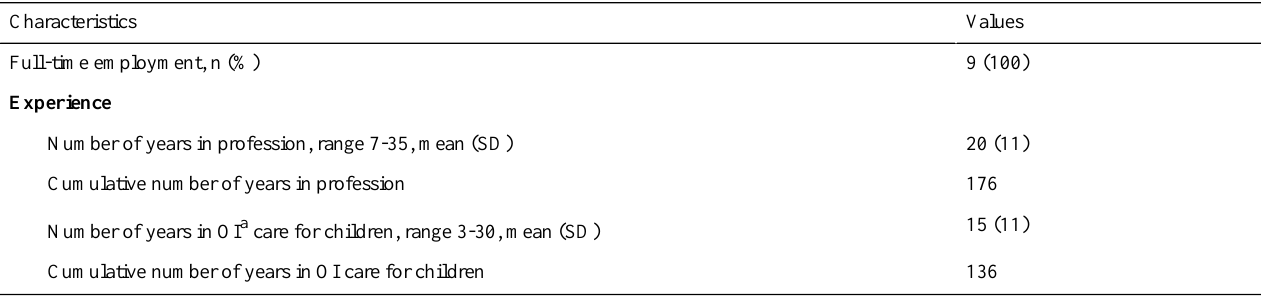
Table 2. Demographic characteristics of the clinicians